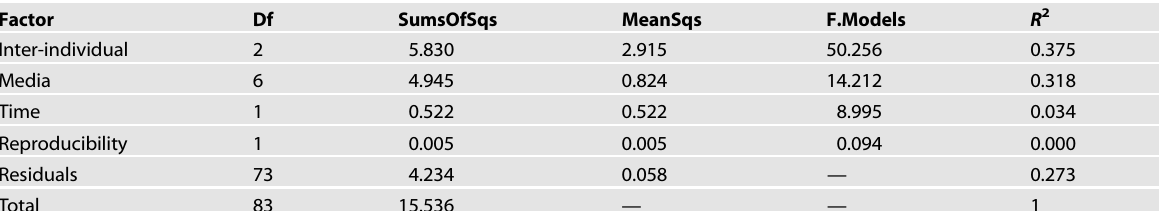
Table 1. PERMANOVA analysis of factors